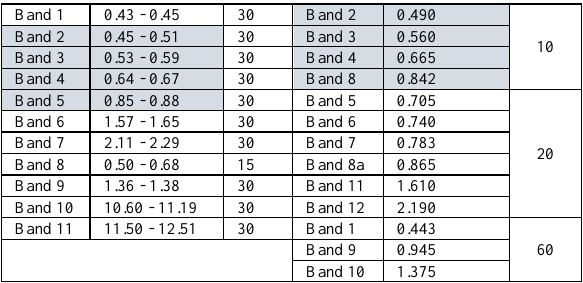
Table 1. Spectral bands and GSD values of datasets